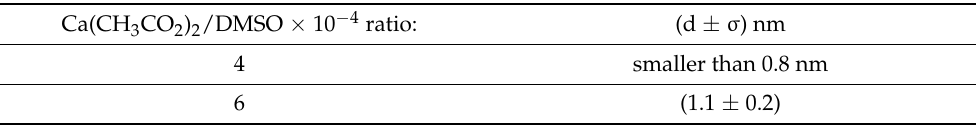
Figure 2. The STM images obtained for dry deposits of CaS with initial Ca(CH 3 CO 2 ) 2 /DMSO ratios of ( a ) 2 × 10 − 4 and ( b ) 6 × 10 − 4 . The insert in ( a ) represents the STM of the graphite substrate employed for the measurements. The particle size distribution obtained from the STM and light scattering measurements for dispersion with a Ca(CH 3 CO 2 ) 2 to DMSO ratio of 6 × 10 − 4 prepared in the microwave are labeled ( c , d ). The calculated volumes of Ca 2+ , S − 2 , and optimized structures of (CaS) n nanoclusters ( n = 1, 2, 3, and 4) in DMSO are summarized in ( e ). The calculations were performed at the DFT/B3LYP/DGZVP level of theory. Table 1. Particle size diameters obtained from light scattering measurements of dispersions prepared in with microwave radiation. The initial Ca(CH 3 CO 2 ) 2 to DMSO concentration ratios of 4 and 6 × 10 − 4